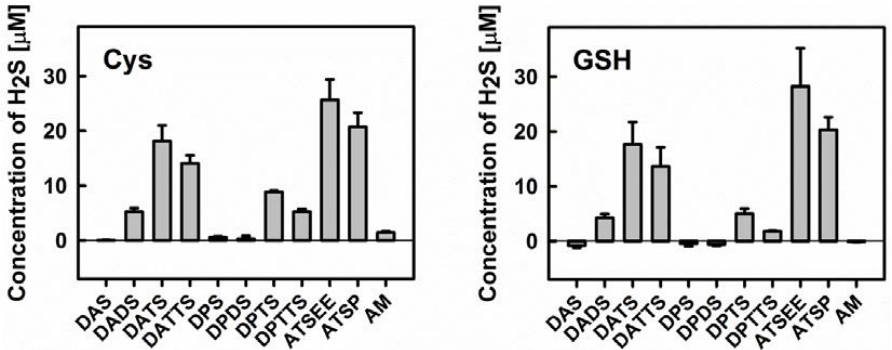
Figure 5. Left: Release of H 2 S from different organic (poly)sulfanes in the presence of cysteine (Cys). Right: Release of H 2 S from different organic (poly)sulfanes in the presence of reduced glutathione (GSH). Concentrations of H 2 S were quantified via the Methylene Blue method after 10 min of incubation with 800 µM Cys/GSH and 200 µM organic (poly)sulfanes ( n = 3).